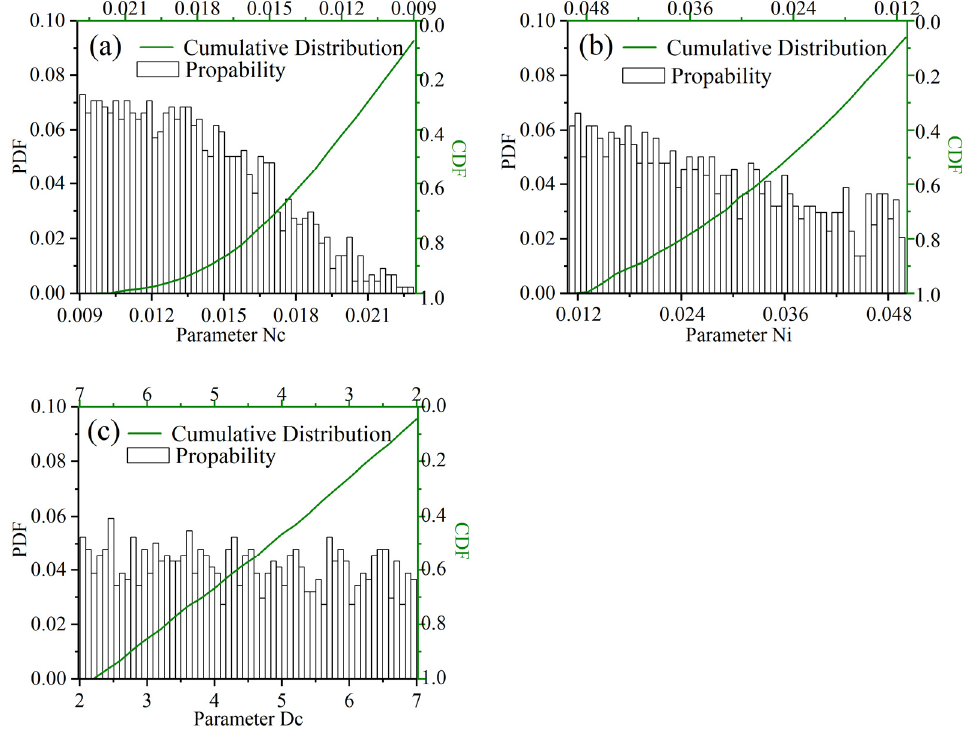
Figure 5. Parameter probability density plots and cumulative distribution plots: ( a ) Parameter Nc; ( b ) Parameter Ni; ( c ) Parameter Dc. The x -axis represents the posterior distribution of the parame- ters.